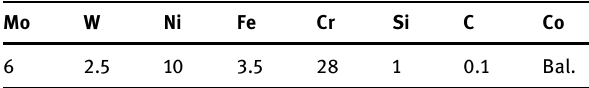
Table 3: Chemical composition of cobalt - based powder ( wt% )